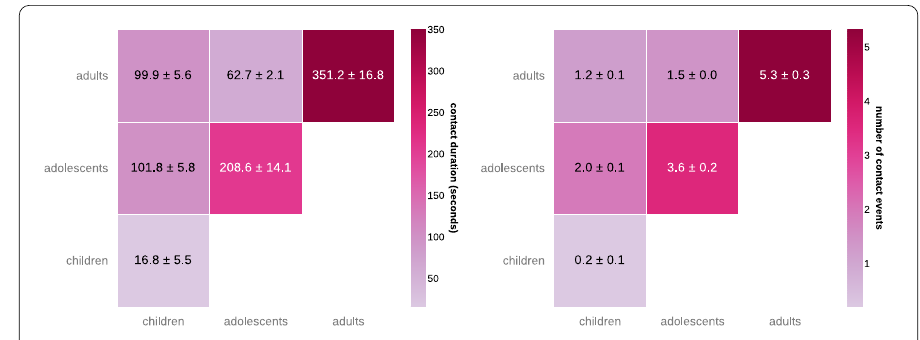
Figure 3 Inter-household contact matrices. Contact matrices giving the daily mean contact durations ( ± standard deviation) in seconds per capita (left panel) and the daily mean contact events ( ± standard deviation) per capita (right panel) by